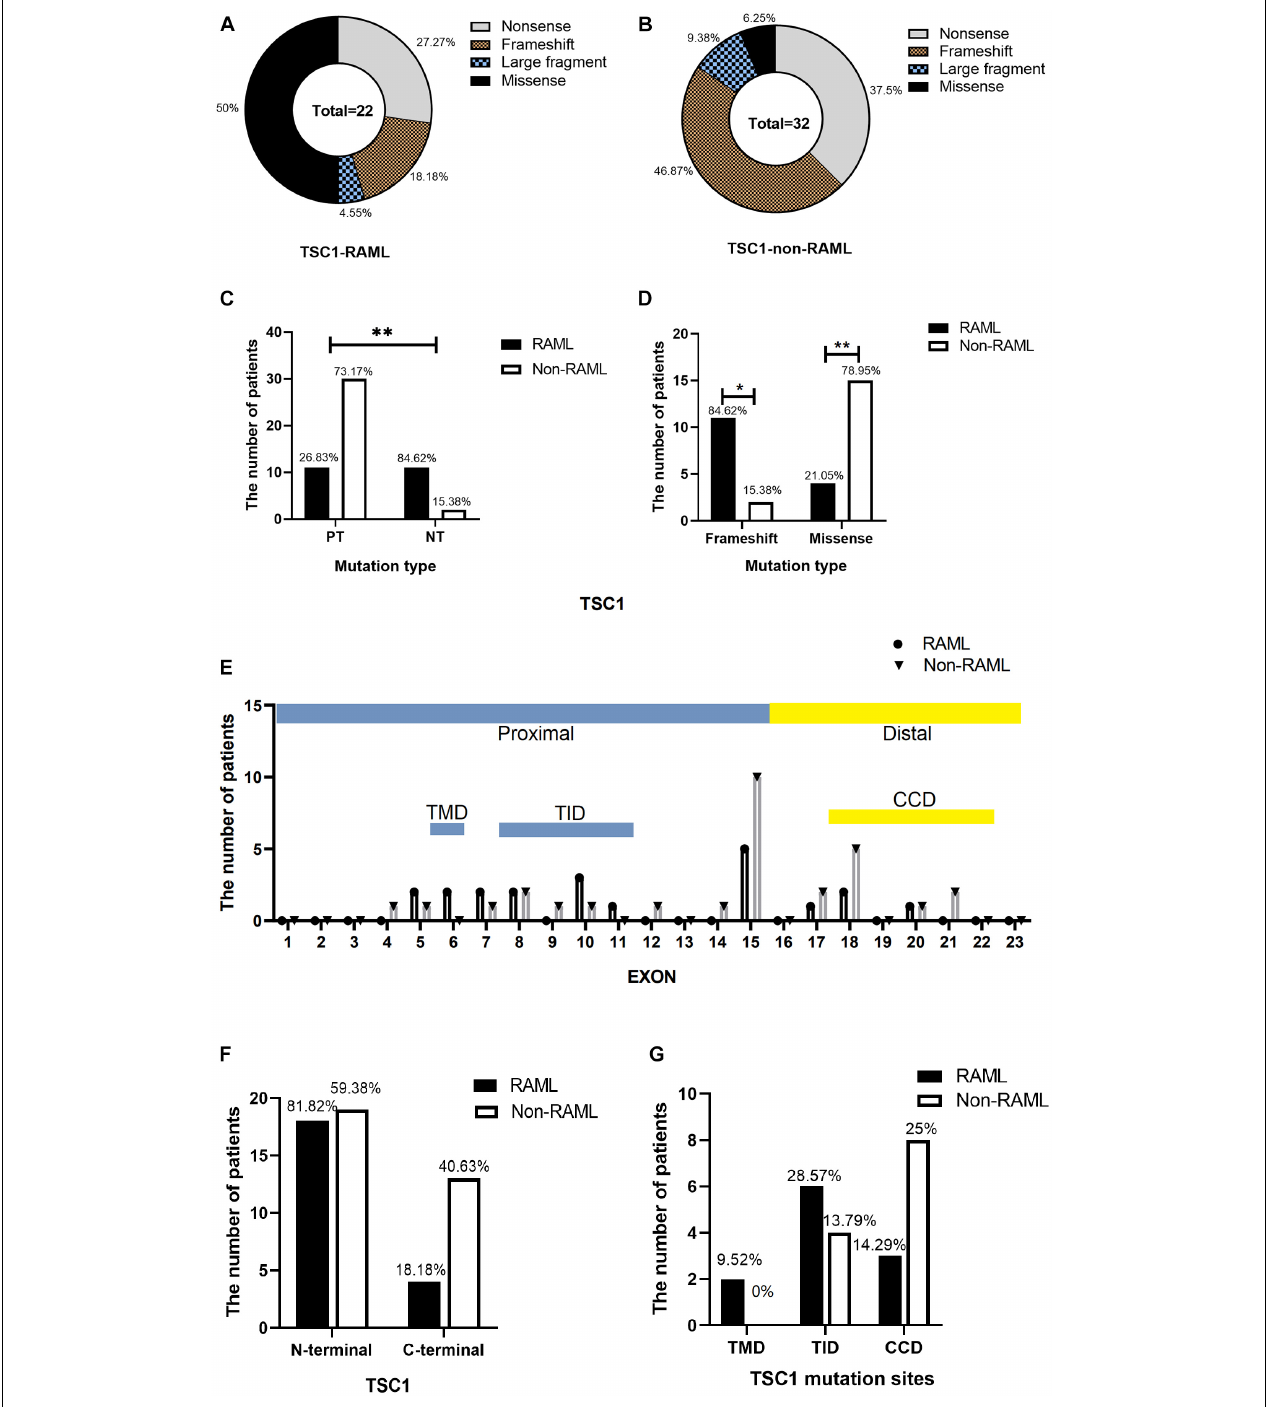
FIGURE 2 | Distribution of TSC1 gene mutations. (A) Categorization of TSC1 gene mutation in patients with RAML. (B) TSC1 gene mutation types without RAML. (C) Distribution of TSC1 protein truncation mutation (PT) and protein non-truncation mutation (NT) in RAML and non-RAML patients. (D) Distribution of TSC1 frameshift mutation and missense mutation in RAML and non-RAML patients. ∗ p < 0.05, ∗∗ p < 0.01. (E) The distribution of TSC1 mutation sites in patients with or without RAML. TMD, transmembrane domain is encoded by exon 6. TID, tuberin interaction domain is encoded by exon 8–11. CCD, coiled coil domain is encoded by exon 18–22. (F) Distribution of N-terminal and C-terminal mutations of TSC1 in RAML and non-RAML patients. (G) The relationship between gene mutation affected or potentially affected TMD, TID, CCD, and RAML. Transmembrane domain (TMD) is encoded by exon 6, tuberin interaction domain (TID) is encoded by exons 8-1 and coiled coil domain (CCD) is encoded by exon